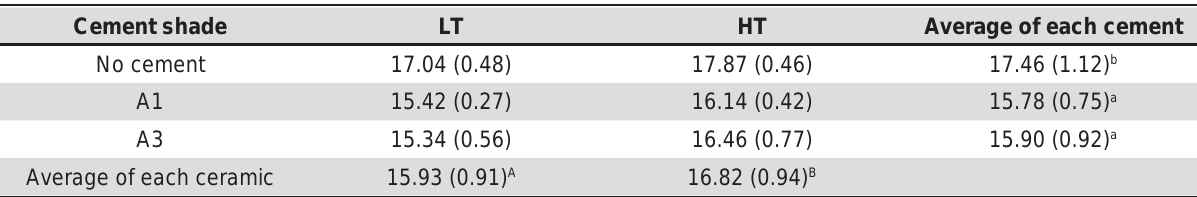
Table 2- Translucency parameter (TP) means (standard deviations) of LT and HT ceramics before and after cement insertion. The means followed by different letters [upper case letters within column (ceramic) and lower case letters within (cid:85)(cid:82)(cid:90)(cid:3)(cid:11)(cid:70)(cid:72)(cid:80)(cid:72)(cid:81)(cid:87)(cid:12)(cid:64)(cid:3)(cid:68)(cid:85)(cid:72)(cid:3)(cid:86)(cid:76)(cid:74)(cid:81)(cid:76)(cid:191)(cid:70)(cid:68)(cid:81)(cid:87)(cid:79)(cid:92)(cid:3)(cid:71)(cid:76)(cid:73)(cid:73)(cid:72)(cid:85)(cid:72)(cid:81)(cid:87)(cid:3)(cid:11)(cid:83)(cid:31)(cid:19)(cid:17)(cid:19)(cid:24)(cid:12)